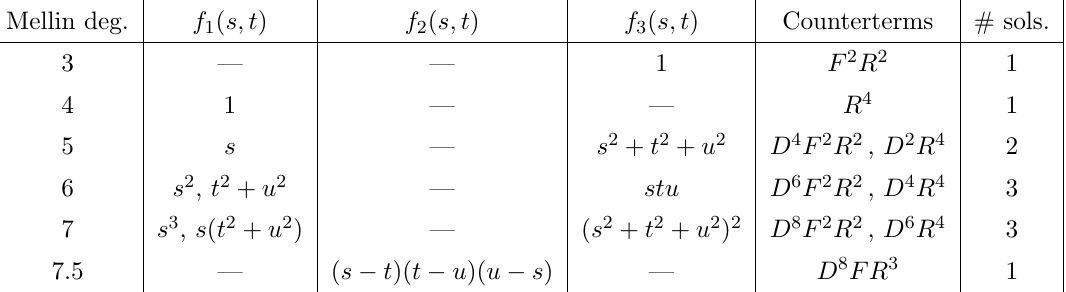
Table 3 . Counterterms in N = 6 supergravity, up to 15